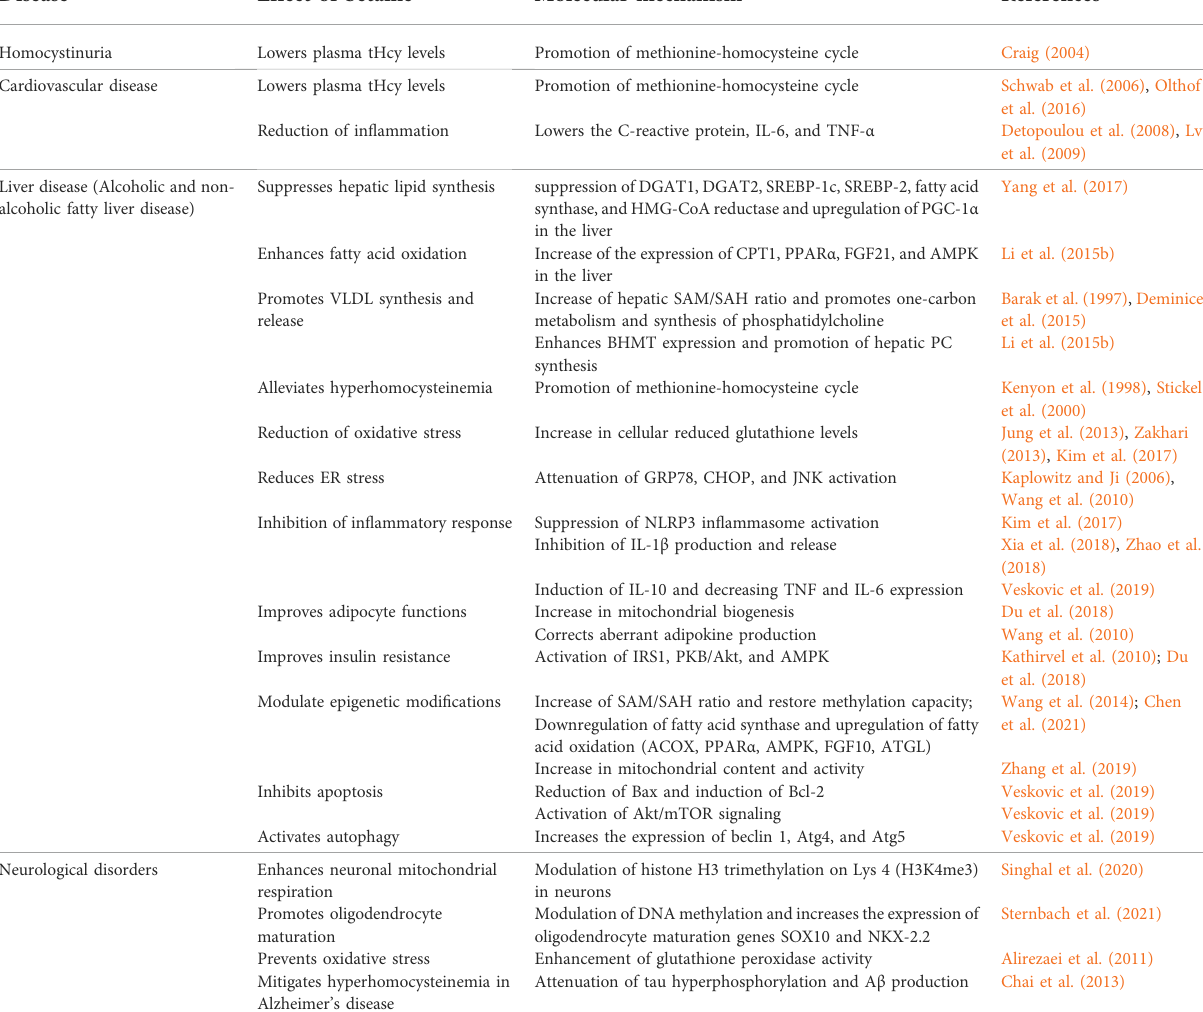
TABLE 2 A summary of the health implications of betaine with molecular